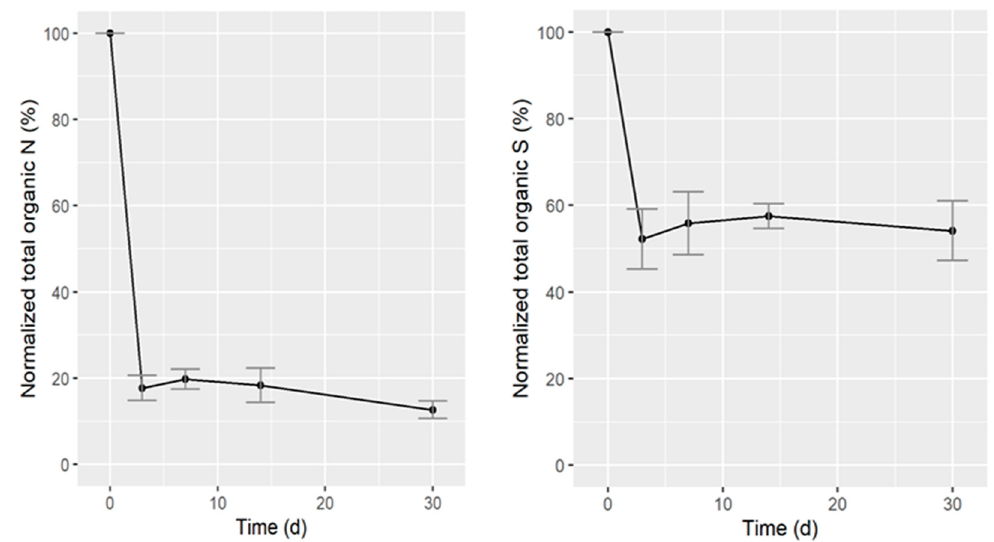
Figure 3. Total N and S mass of digested CGP in bags over time, normalized to the initial N and S mass. Error bars show standard deviation ( n = 3).